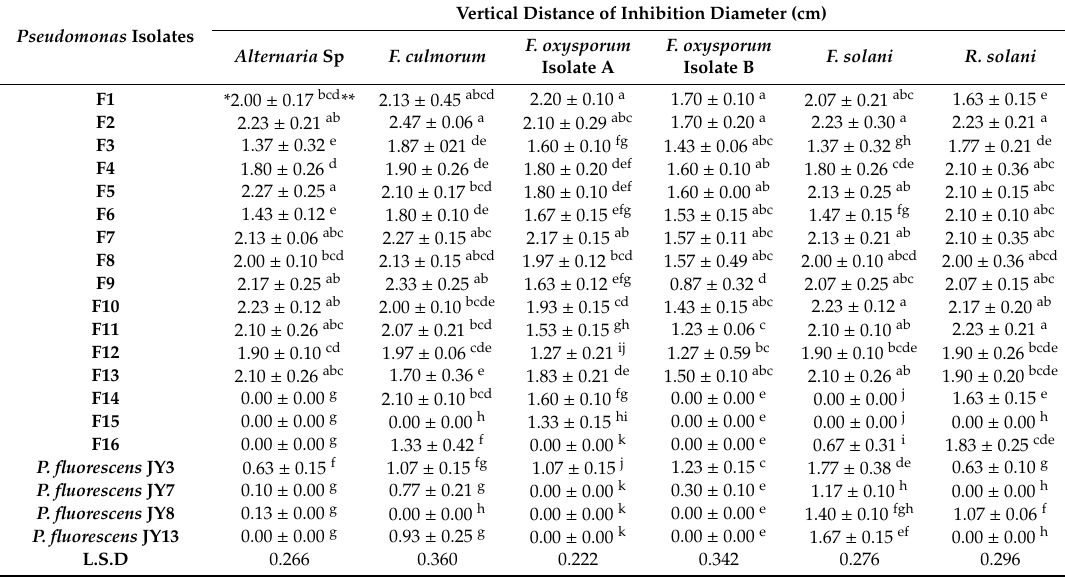
Table2. Antagonistice ff ectsoffluorescent Pseudomonas isolatesagainstgrowthofsomephytopathogenic fungi using the dual culture